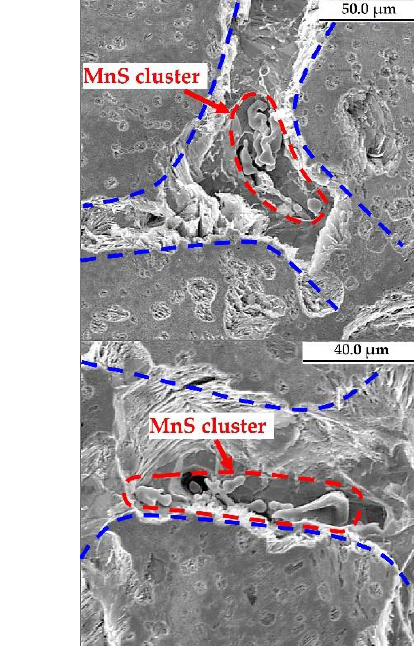
Figure 5. Distribution of large-size MnS inclusions along the slab thickness of medium carbon struc- tural steel 45#.